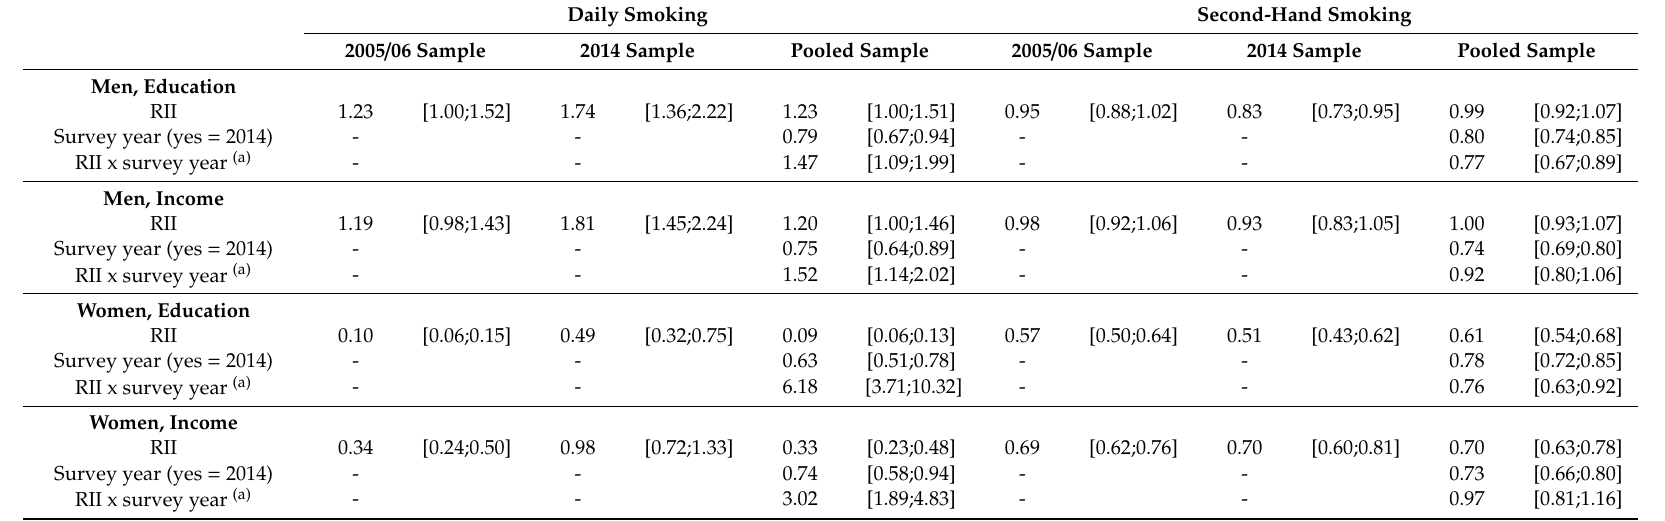
Table 4. RII from the age-adjustedPoisson regressions, stratified by sex and